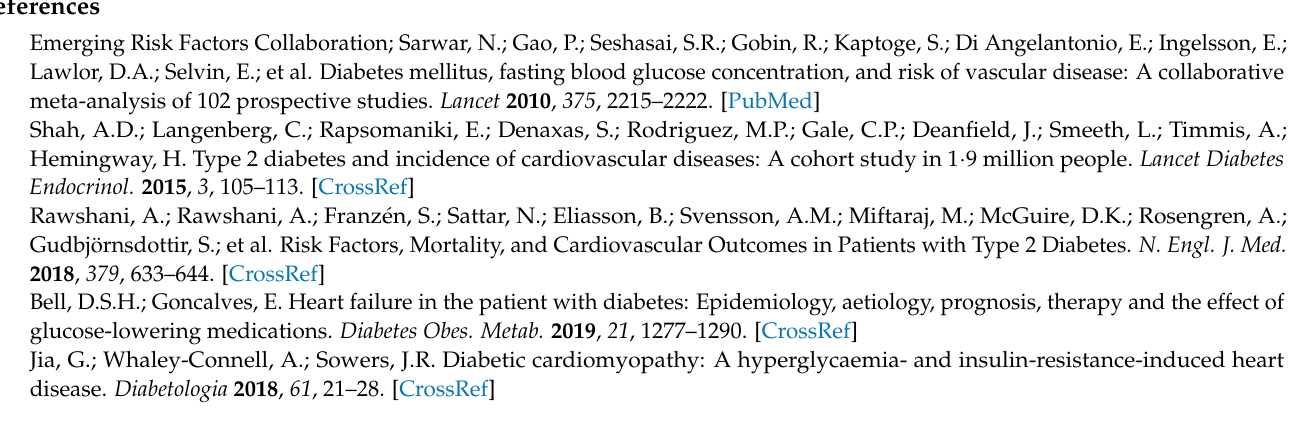
Table S1: Patients’ baseline characteristics based on the type of